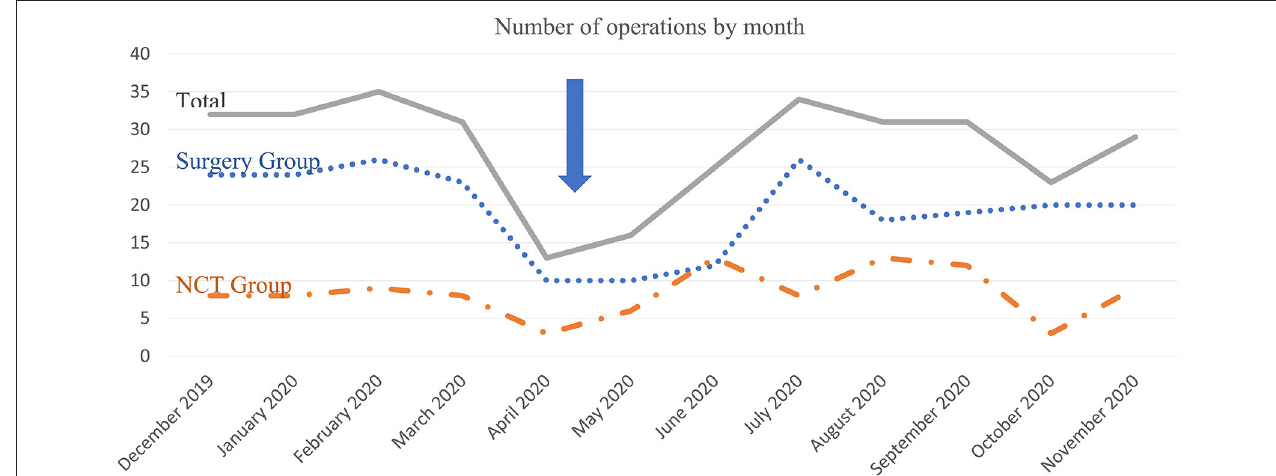
FIGURE 1 | Number of operations by